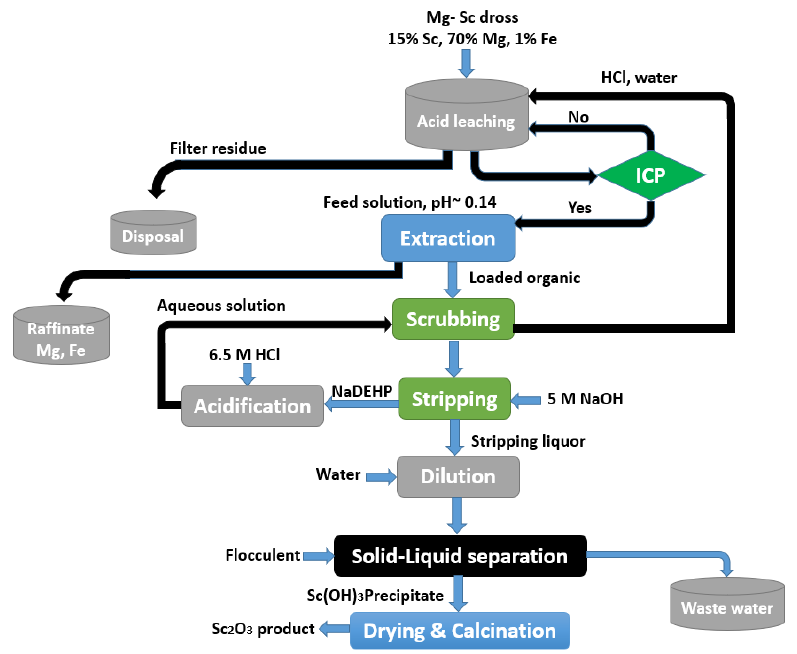
Figure 14. Scandium recovery from Mg–Sc dross, adapted from [16].